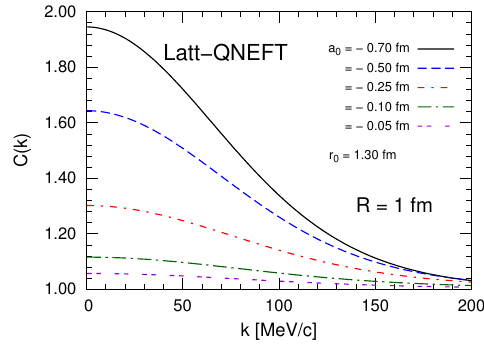
Figure 1. J /ψ - N correlation function computed with Eq. (5) for a source radius of R = 1 fm. The a 0 and r 0 values are from the lattice QCD simulations of Refs. [39–41], extrapolated to the physical pion mass with the QNEFT of Ref.